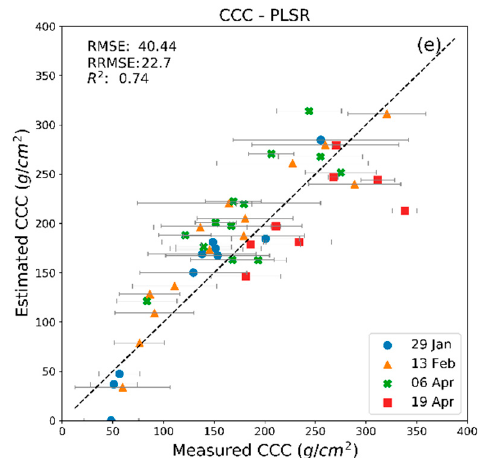
Figure 3. Best performing algorithms for the retrieval of ( a ) LAI, ( b ) LCC, ( c ) FVC, ( d ) FAPAR, and ( e ) CCC for the Maccarese test site. The horizontal error bars represent the standard deviation of measurements inside each ESU. Vertical error bars represent uncertainty estimates using GPR for FVC ( c ).